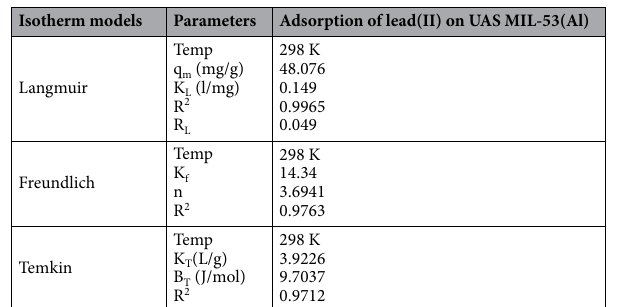
Table 4. Isotherm parameters values of Langmuir, Freundlich, Temkin models for the adsorption of Pb(ll) on UAS MIL-53(Al).